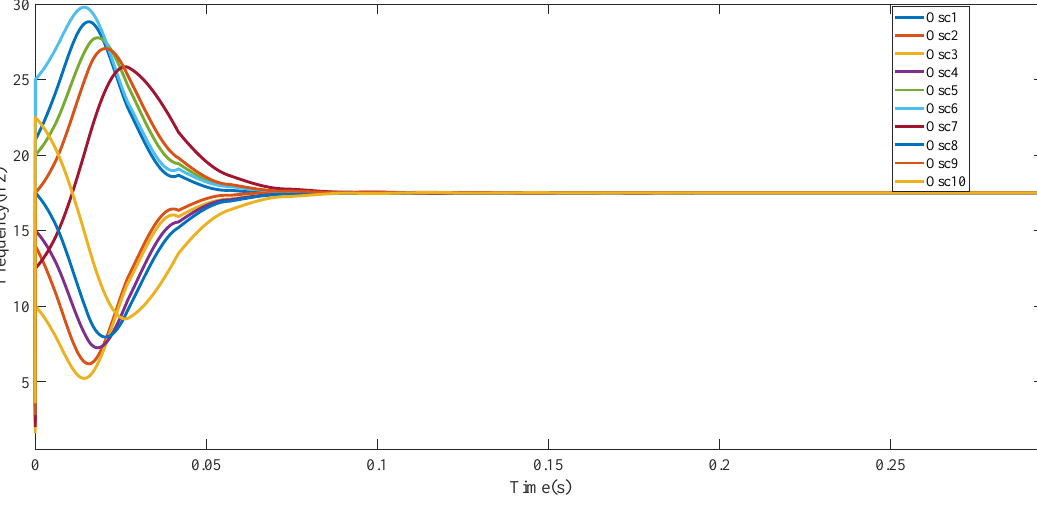
Figure 3. Convergence time and frequency of the stored